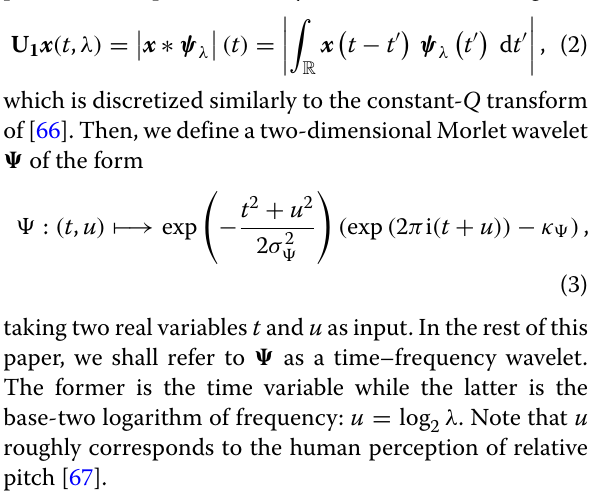
frequency, denoted by log gression. We set the constant quality factor of the wavelet